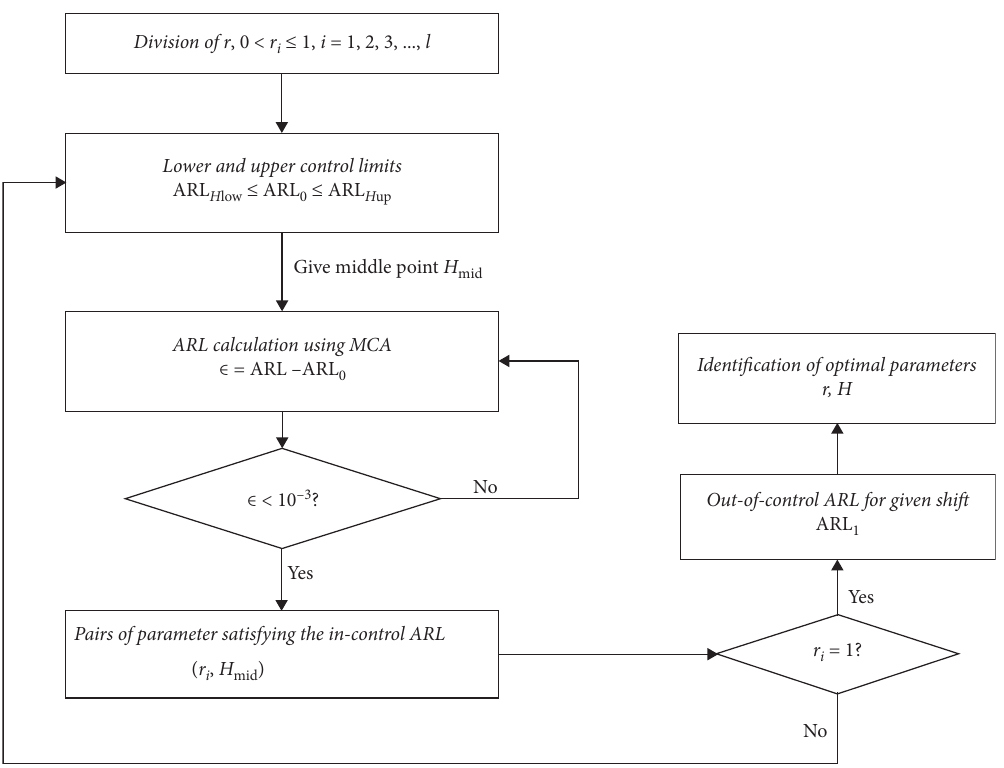
Figure 2: Flowchart for the optimal design of MEWMA control